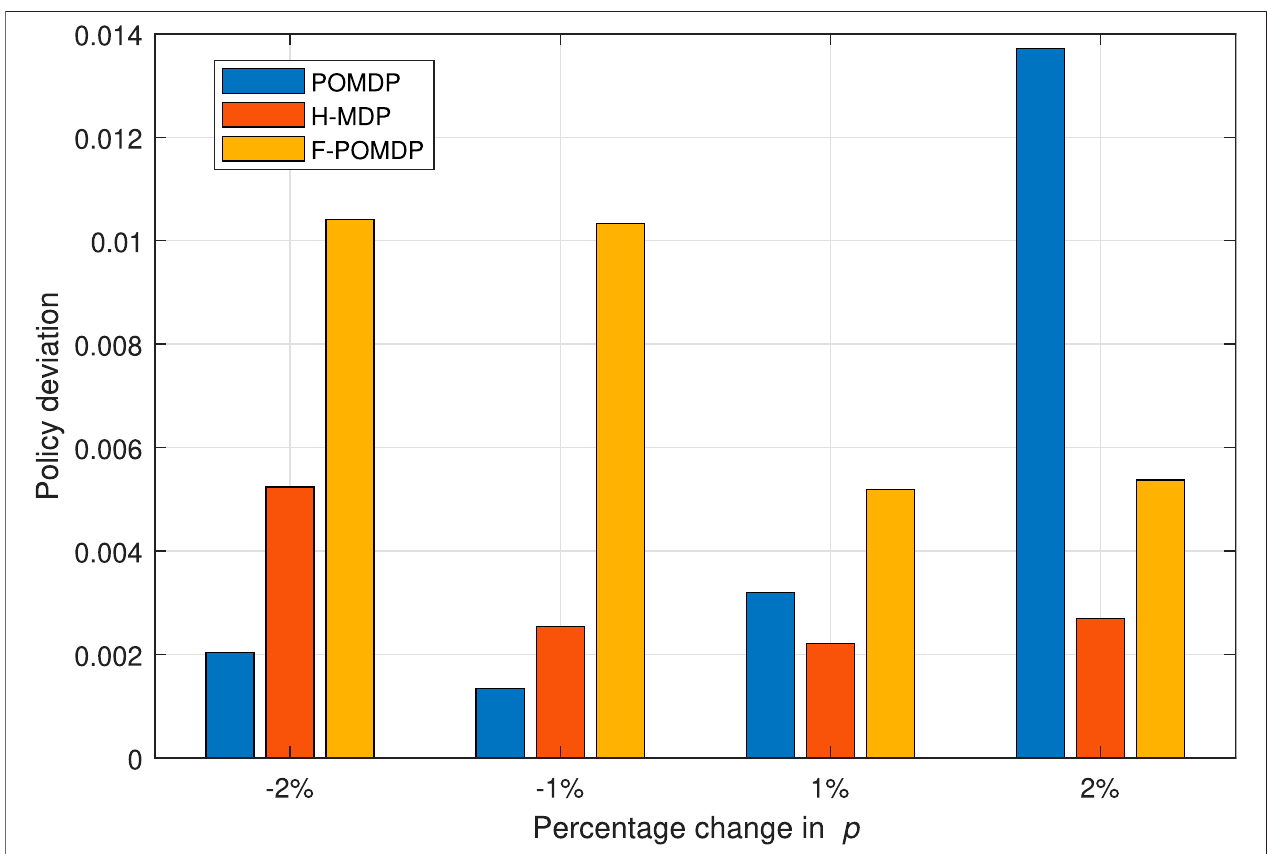
FIGURE 10 | Deviation from the optimal MDP policy of full observability when having an error in estimating the p and r values, for the case of η (cid:2) 0.07.